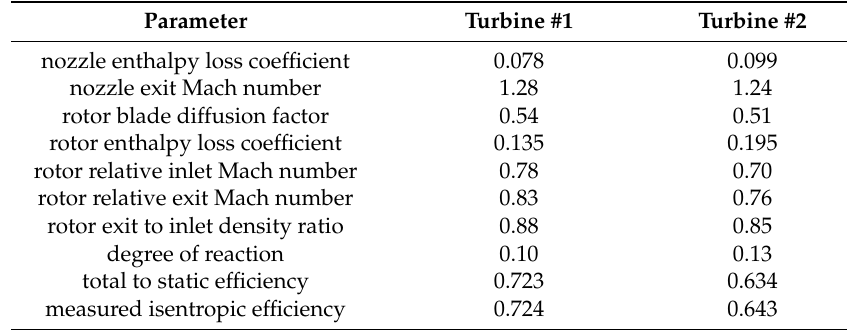
Table 4. Performance simulation and measured results for the two single stage-partial admission steam turbines tested at a factory bench.